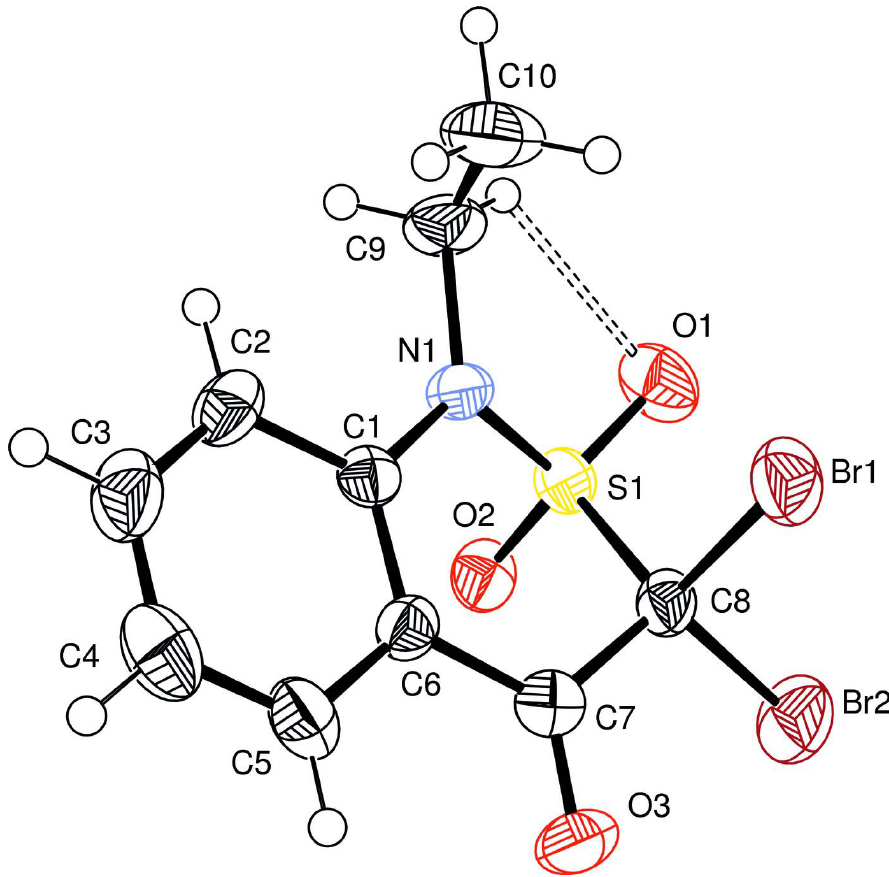
Figure 1 The molecular structure of the title molecule, with the atom-numbering scheme. Displacement ellipsoids are drawn at the 50% probability level. Hydrogen bond is shown as dashed